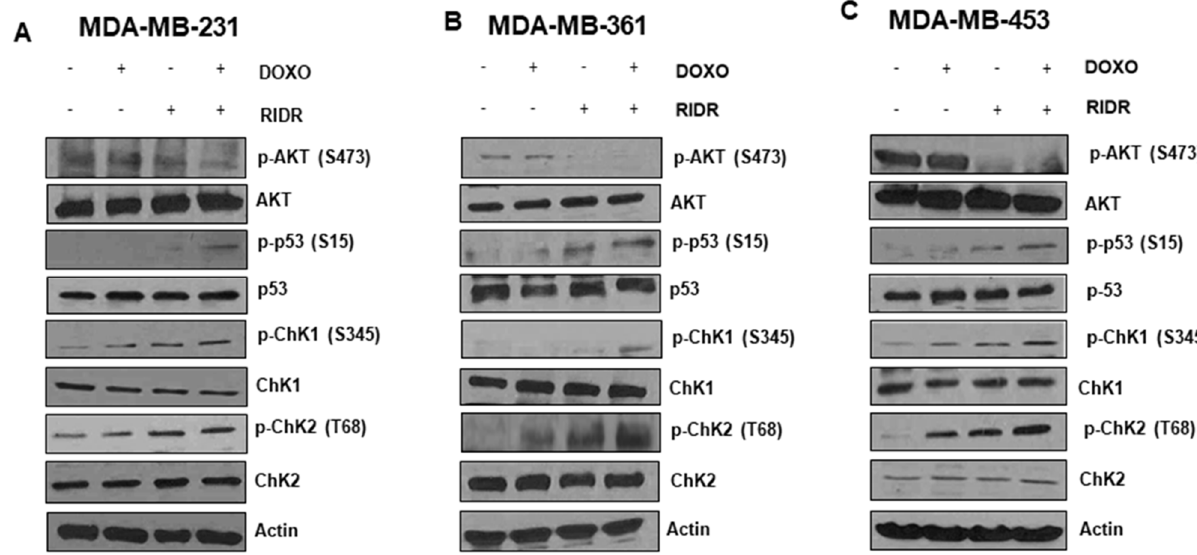
Figure 6. Doxorubicin in combination RIDR-PI-103 inhibits AKT and downstream signaling. Equal number of MDA-MB-231 ( A ), MDA-MB-361 ( B ) and MDA-MB-453 ( C ) cells were treated with vehicle (DMSO), RIDR-PI-103 (10 µM), doxorubicin (125 nM) and combination of both for 24 h and cell lysates were collected and immunoblotted using p-AKTSer473, AKT, p-P53Ser15, P53, p-CHK1S345, CHK1, p-CHK2T68 and CHK2 antibodies. Actin served as loading control.